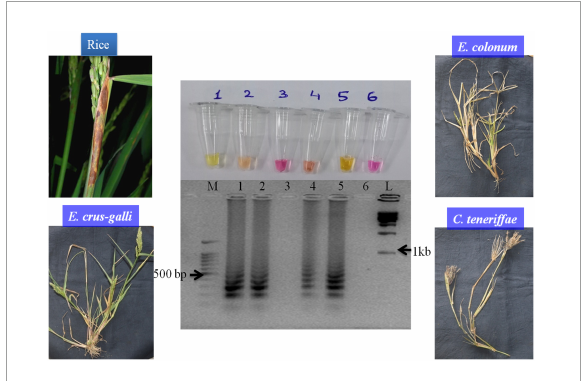
FIGURE4 The LAMP assay with infected rice leaves along with three weed species. M: 100 bp (Promega); 1: S. oryzae NAIMCC-F-01632; 2: S. oryzae infected tissue; 3: Cyperus teneriffae infected tissue; 4: Echinochloa crus-galli infected tissue; 5: E. colona infected tissue; and 6: No template control; L: 1 kb (Promega). Middle panel in the figure shows agarose gel electrophoresis results, lower panel shows diseases severity in the samples and upper panel shows reaction